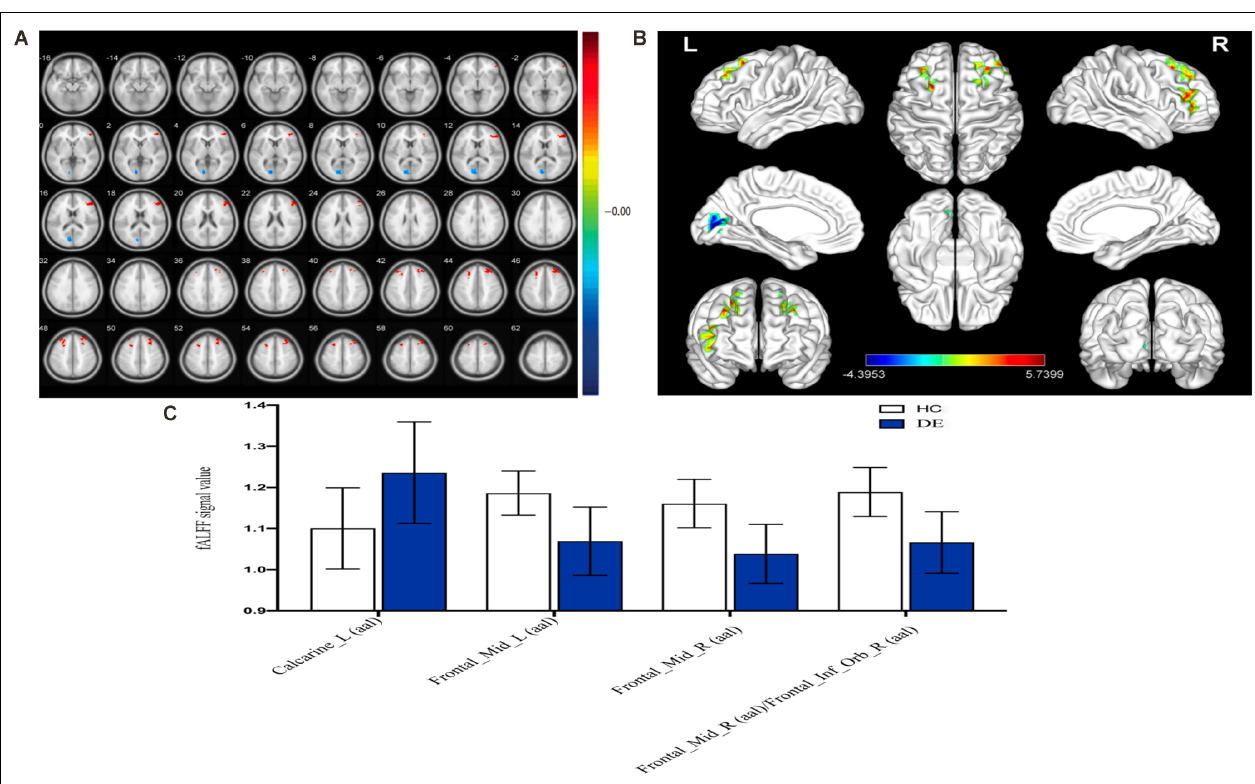
FIGURE 2 | Spontaneous brain activity in the DE and HC groups. (A) The different ALFF regions between the DE and HC group. (B) Significant difference in brain activity in the cerebrum. The red regions indicate higher ALFF values, and the blue regions imply lower AFLL values. (C) The mean ALFF values between DE and HC groups. Abbreviations: fALFF, fractional amplitude of low-frequency fluctuation; L, left; R, right. Calcarine_L (aal), calcarine sulcus; Frontal_Mid_L (aal), left middle frontal gyrus; Frontal_Mid_R (aal), right middle frontal gyrus; Frontal_Mid_R (aal)/Frontal_Inf_Orb_R (aal), right middle frontal gyrus/right inferior frontal gyrus.